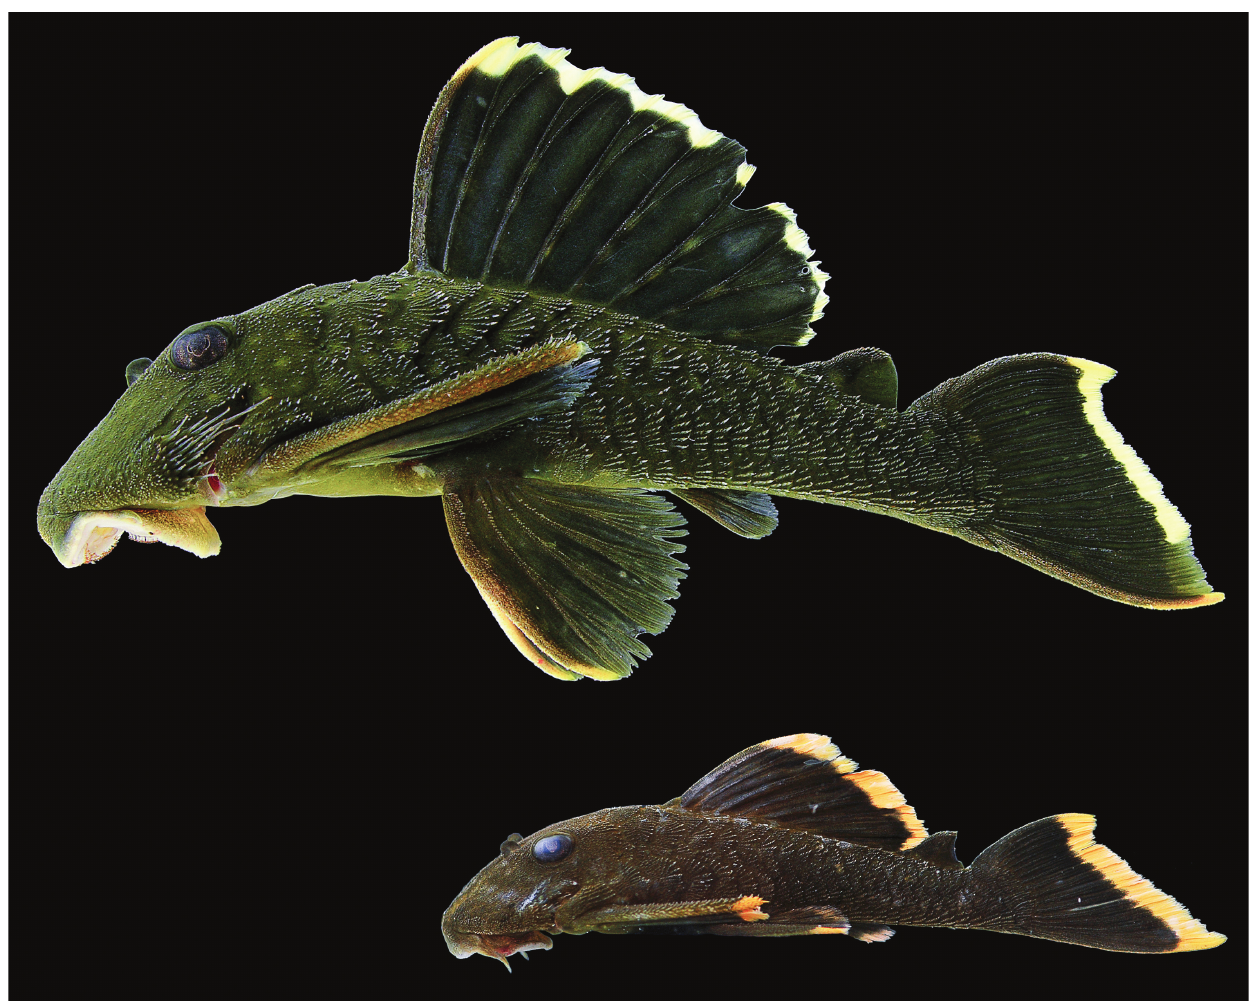
Fig. 6. Lateral view of live specimens of Baryancistrus chrysolomus , (above) adult, MZUSP 97226, paratype, 127.7 mm SL (photo M. Sabaj-Pérez), Brazil, Pará, rio Curuá, rio Iriri drainage; (below) juvenile, INPA 31408, paratype, 80.2 mm SL (photos RRO), Brazil, Pará, rio Xingu, Comunidade do